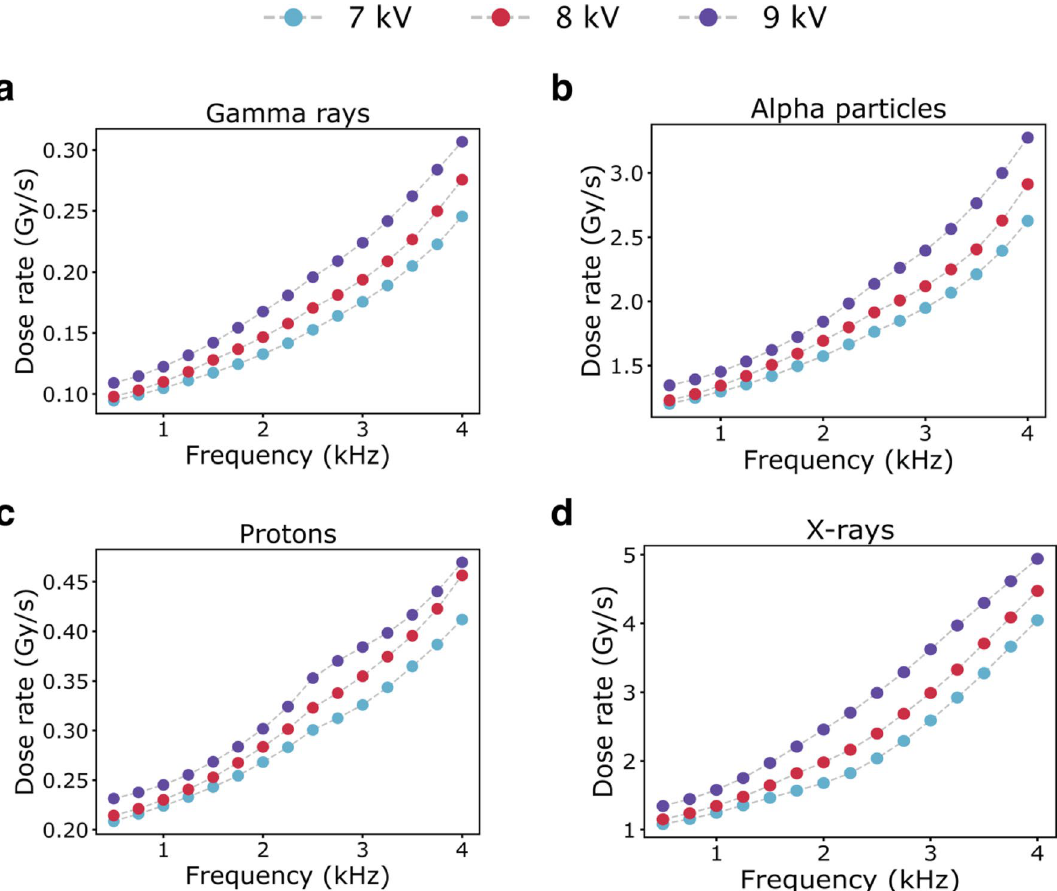
Figure 3. Dose-rate dependence with frequency and voltage. The plot of average dose rate (centroid) versus frequency for the lowest dose-rate cluster as modeled using dose-DNA damage correlation for gamma rays ( a ), alpha particles ( b ), protons ( c ), and X-rays ( d ) at three different applied voltages (7 kV, 8 kV, and 9 kV). The frequency was varied from 0.5 to 4 kHz at increments of 0.25 kHz.